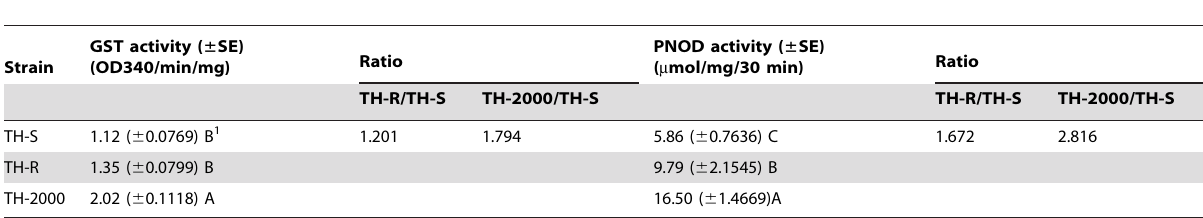
Table 5. Metabolic enzyme activity among thiamethoxam resistance and susceptible B. tabaci .